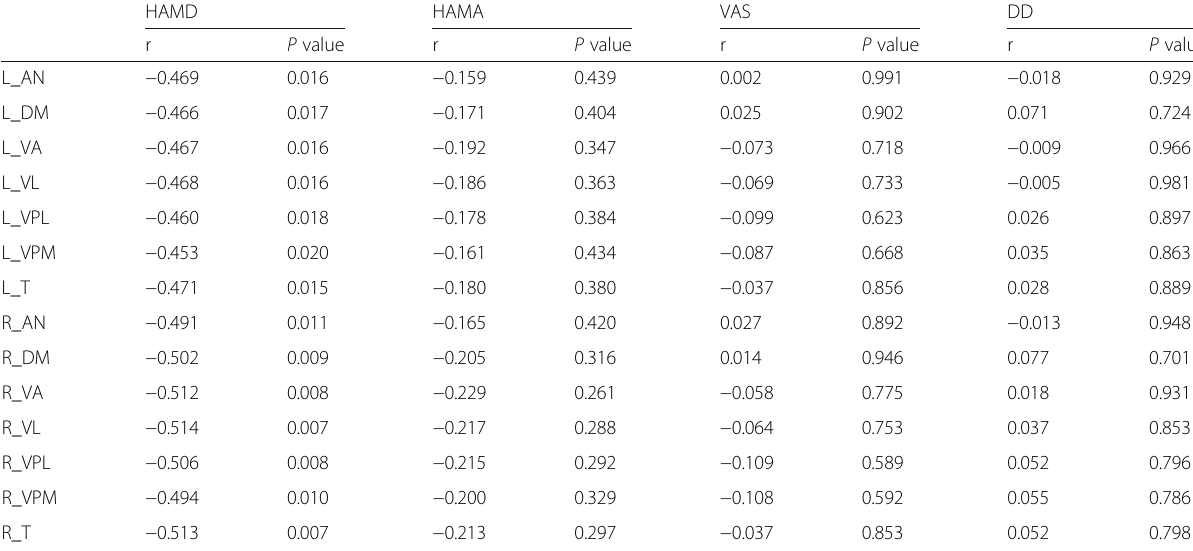
Table 3 The correlation of thalamic subnuclei volume with the clinical variables HAMD